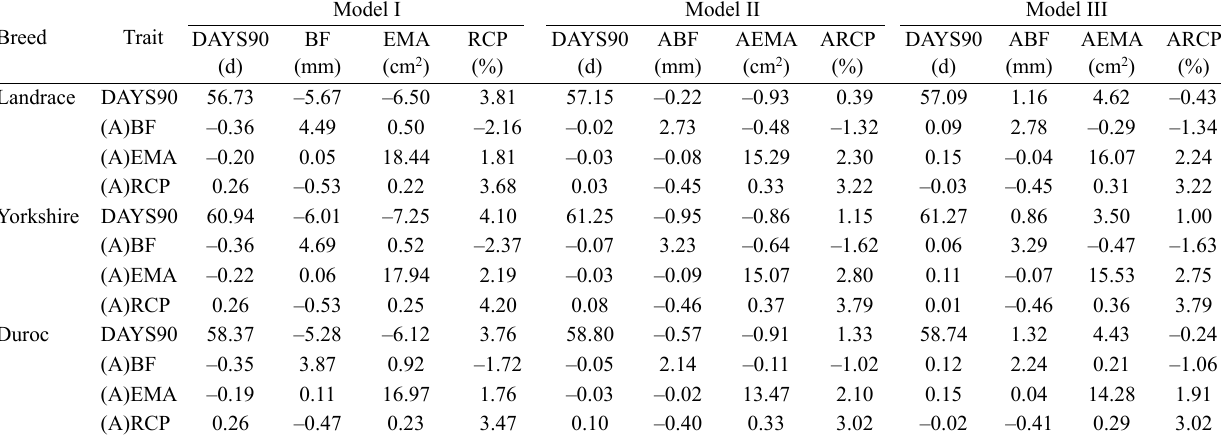
Table 5. Environmental variances (diagonals), covariances (above the diagonals), heritability estimates (h 2 ) and genetic correlation coefficients (below the diagonals) of growth and ultrasound measures by breeds Model I Model Breed Trait